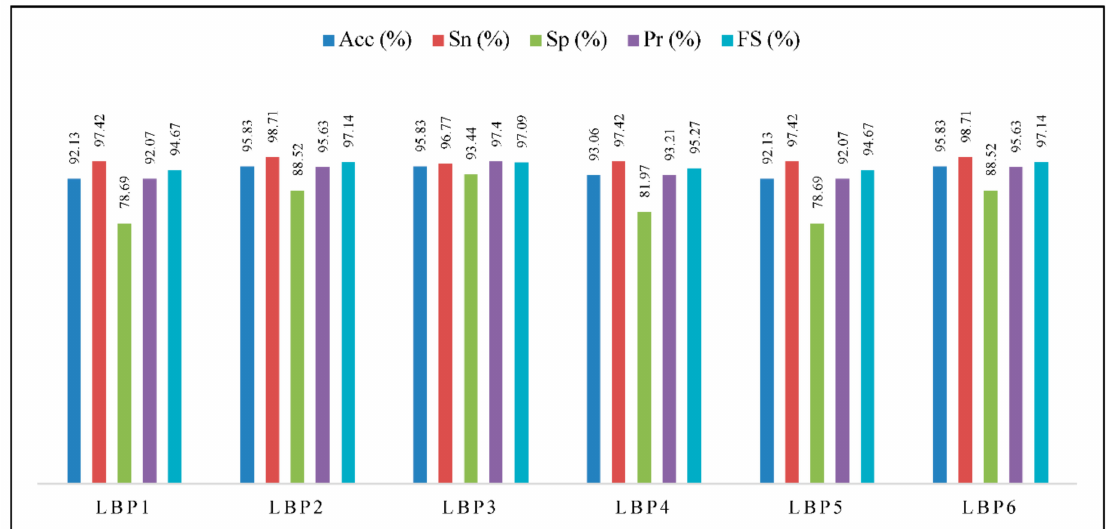
Figure 14. Results of SVM using geometrical and LBP features ( LBP 1 : LBP 8,1 , LBP 2 : GF_LBP 8,1 , LBP 3 : GF_LBP 8,1 _PCA , LBP 4 : LBP 16,2 , LBP 5 : GF_LBP 16,1 , LBP 6 : GF_LBP 16,1 _PCA, Acc: accuracy,